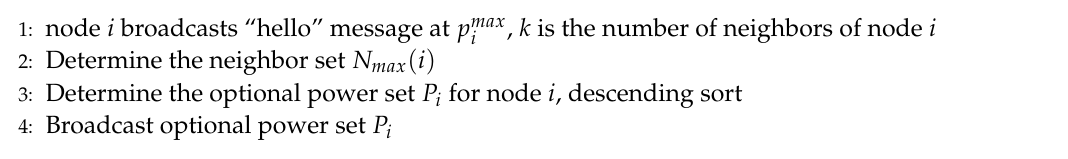
Algorithm 1 EBTG power